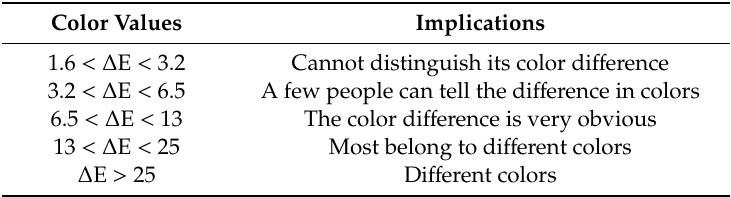
Table 1. General color values and their corresponding